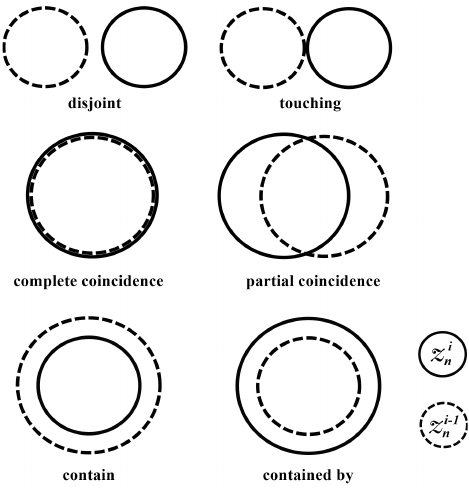
Figure 3. Spatial relationship between a pair of zones ( z i − 1 n , z i n )